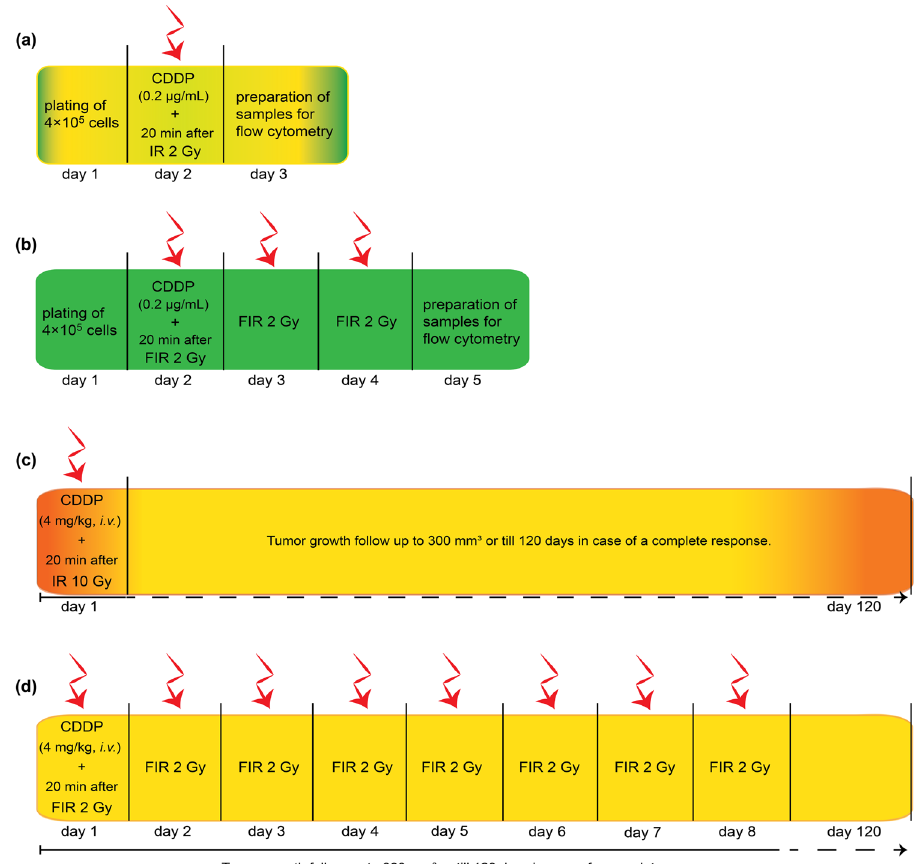
Figure 1. Scheme of the treatment of HPV-negative (FaDu) and HPV-positive (2A3) cells and tumors with concurrent cisplatin (CDDP) and a single-dose or fractionated irradiation regimen. ( a ) Time course of cell treatment with concurrent CDDP and a single-dose irradiation (2 Gy, IR) on day 2 for flow cytometry analyses. ( b ) Time course of cell treatment with concurrent CDDP fractionated irradiation regimen (3 × 2 Gy, FIR) for flow cytometry analyses. ( c ) Time course of tumor treatment with concurrent CDDP and IR (10 Gy) ( d ) Time course of tumor treatment with concurrent CDDP and FIR (8 × 2 Gy). CDDP was injected intravenously 20 min prior to single-dose or fractionated irradiation regimen on the first day